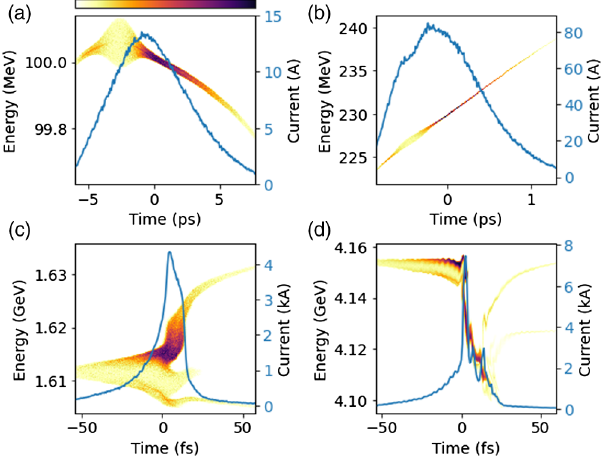
FIG. 7. Generation of a short bunch train at the LCLS-II cuS beamline. Longitudinal phase space: (a): after the laser heater, (b): after BC1, (c): after BC2, and (d) in the middle of soft x-ray self seeding chicane, with an effective R 56 of 0.3 mm. The colorbar above (a) shows the relative density for each plot. See